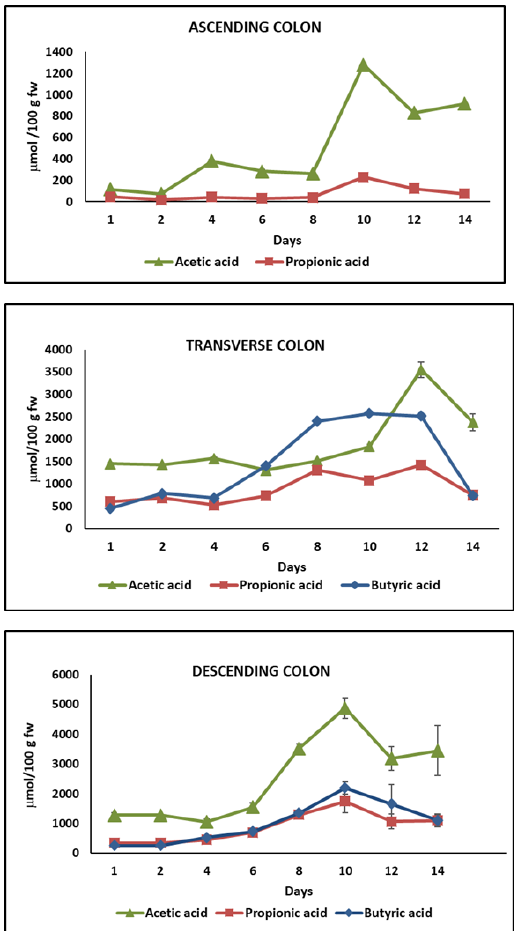
Figure 6. Concentration (µmol/100 g fw of slurry) of the main short-chain fatty acids (SCFAs) in the ascending colon (AC), transverse colon (TC), and descending colon (DC) during the colonic fermentation of HPP-treated onion. Data are the mean values ± standard deviation of three different determinations ( n = 3).